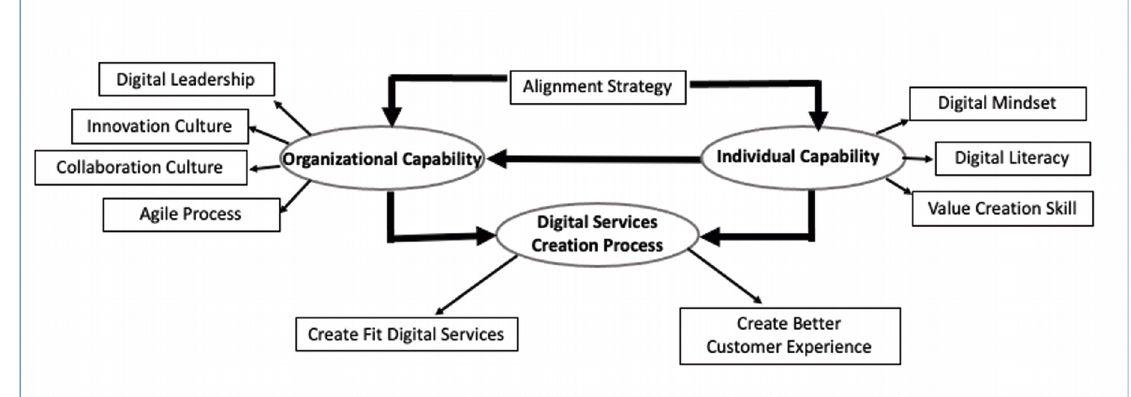
Figure 2. Proposed Digital Capability Maturity